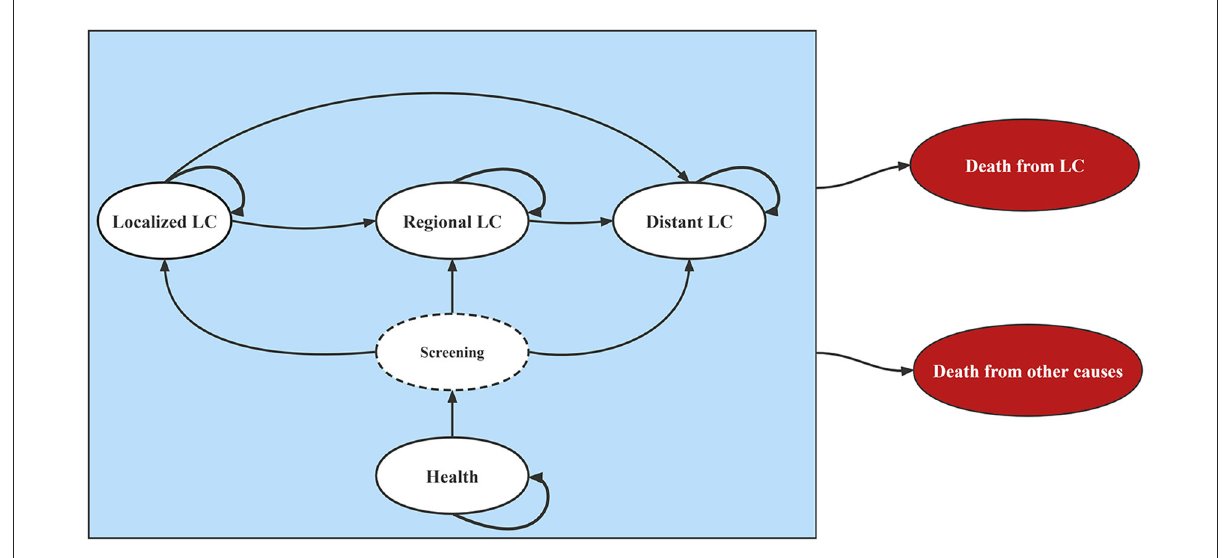
FIGURE1 Diagram of Markov model. LC, lung